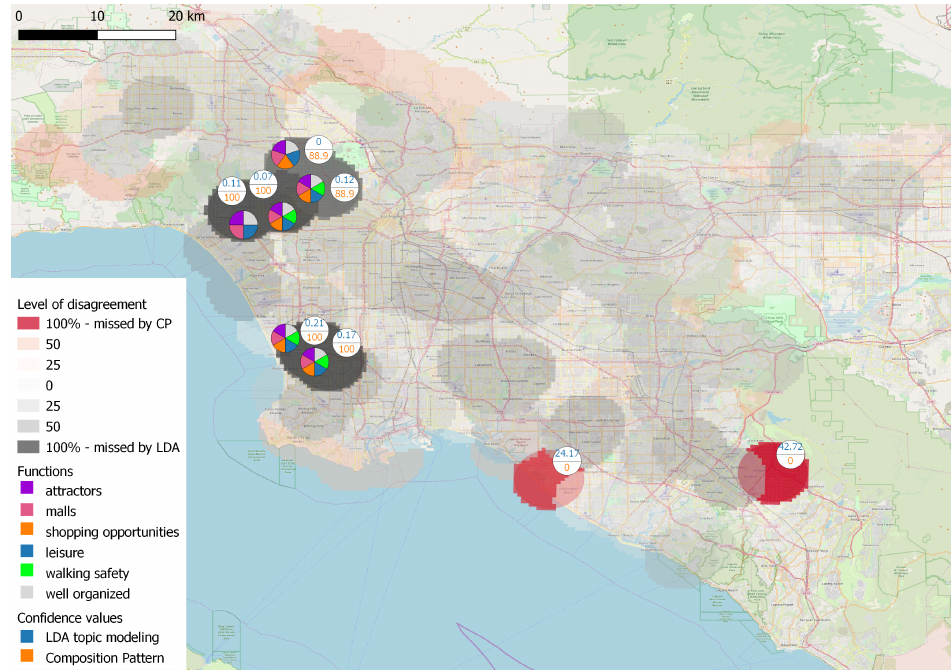
Figure 5. Regions where there is significant disagreement between approaches.